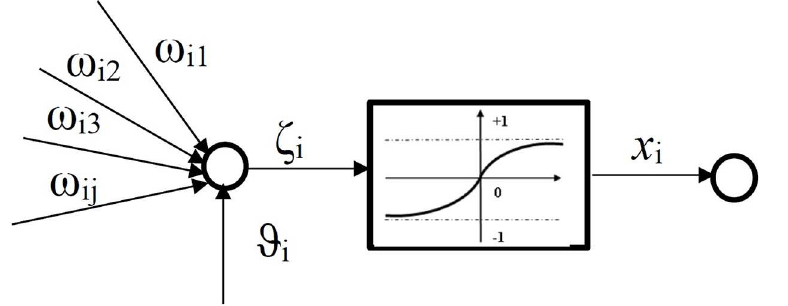
Fig 12. Single-Input